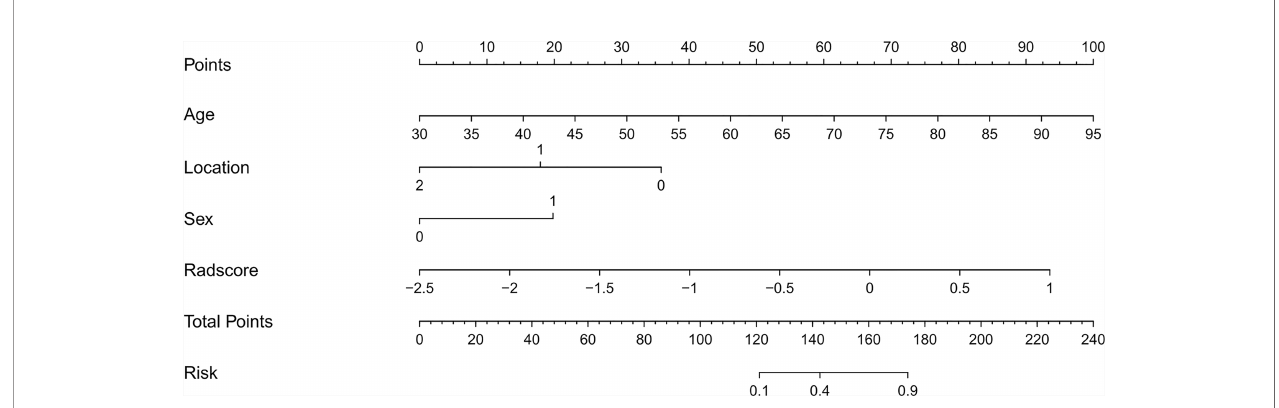
FIGURE 4 | The CT-based radiomics nomogram. The radiomics nomogram was built in the training cohort, with the radiomics signature, sex (0 is male, 1 is female), age, and tumor location (0 is antrum, 1 is gastric body, 2 is